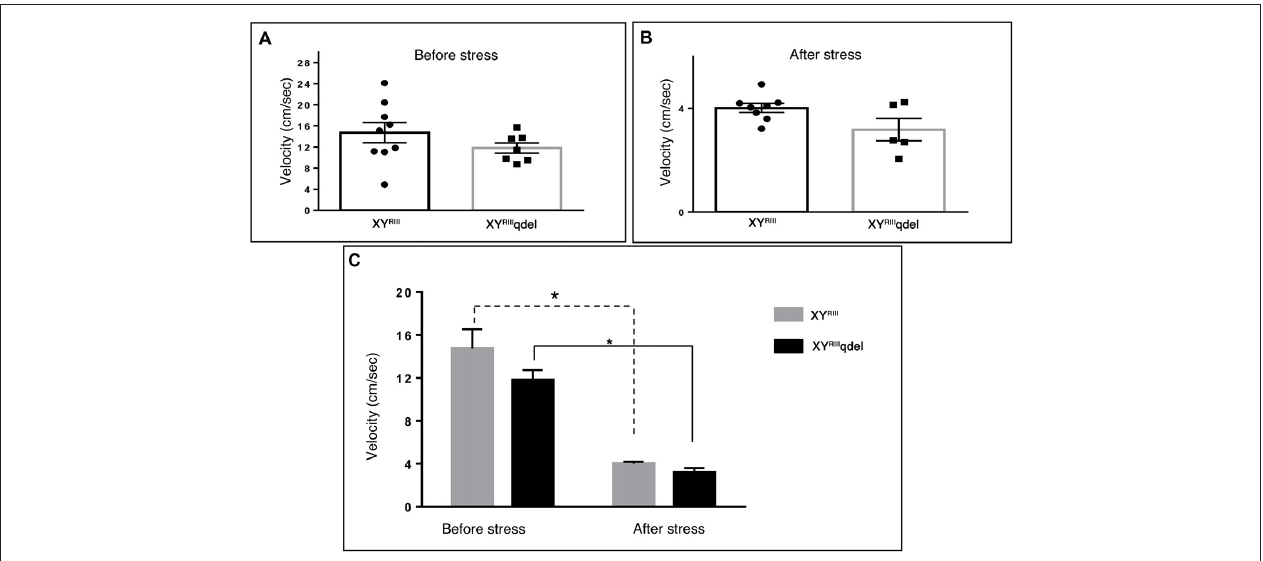
FIGURE 5 | The status of normal locomotion in XY RIII qdel and XY RIII mice before and after stress: velocity. Before and after stress the mice did not show any difference in the velocity of their movement as such in between genotypes (A,B) whereas while comparing movements before and after stress episodes both the groups have shown significant reduction (C) . Data are expressed as the mean ± SEM. Solid line represents the difference between XY RIII qdel groups and dotted line represents the wild type before and after stress. ∗ P < 0.05, n = 8–10 per group in before stress, n = 6–8 per group in after stress experiments.